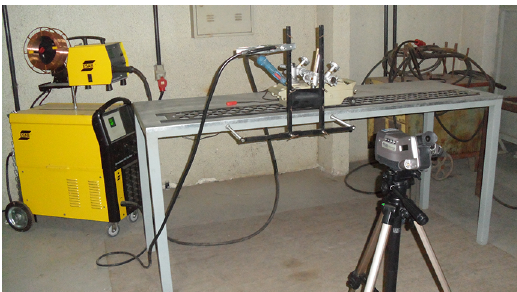
Figure 6. Experimental bench for IR measurements. The infrared images were recorded on the backside of the absorbing part